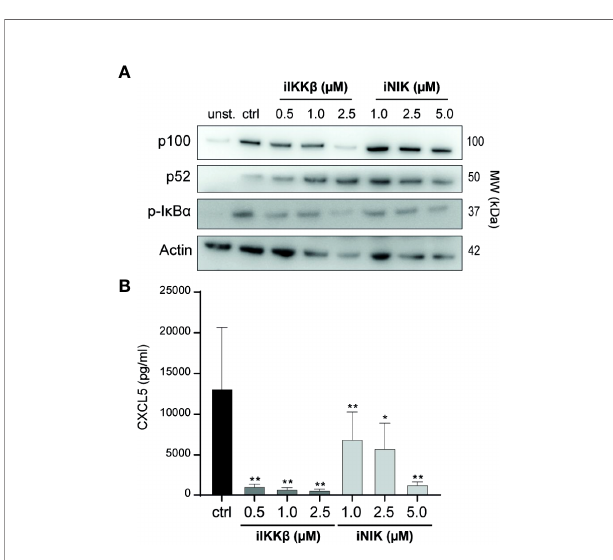
FIGURE 3 | Treatment with small molecule inhibitors of IKK b and NIK reduces NF- k B signaling in T m sup stimulated ECs. (A, B) ECs were left unstimulated (unst.) or stimulated with T m sup for 72h and treated with DMSO (ctrl) or with inhibitors of IKK b (iIKK b ) or NIK (iNIK) at different concentrations. (A) Representative western blot image of p100, p52 and p-I k B a expression in ECs, actin served as loading control. (B) ELISA quanti fi cation of CXCL5 protein production by ECs ( n= 5). Dark gray; iIKK b , light gray; iNIK. **p < 0.01, ***p <